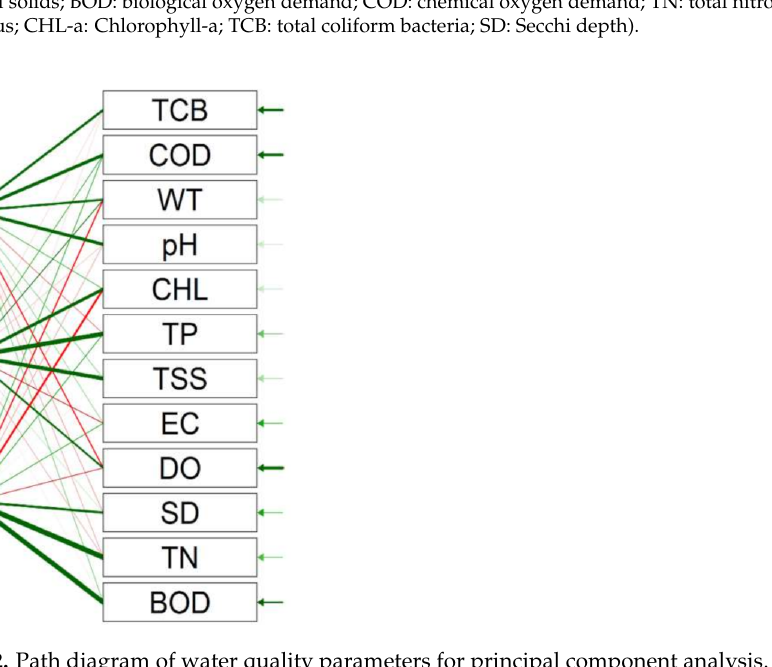
Figure 12. Path diagram of water quality parameters for principal component